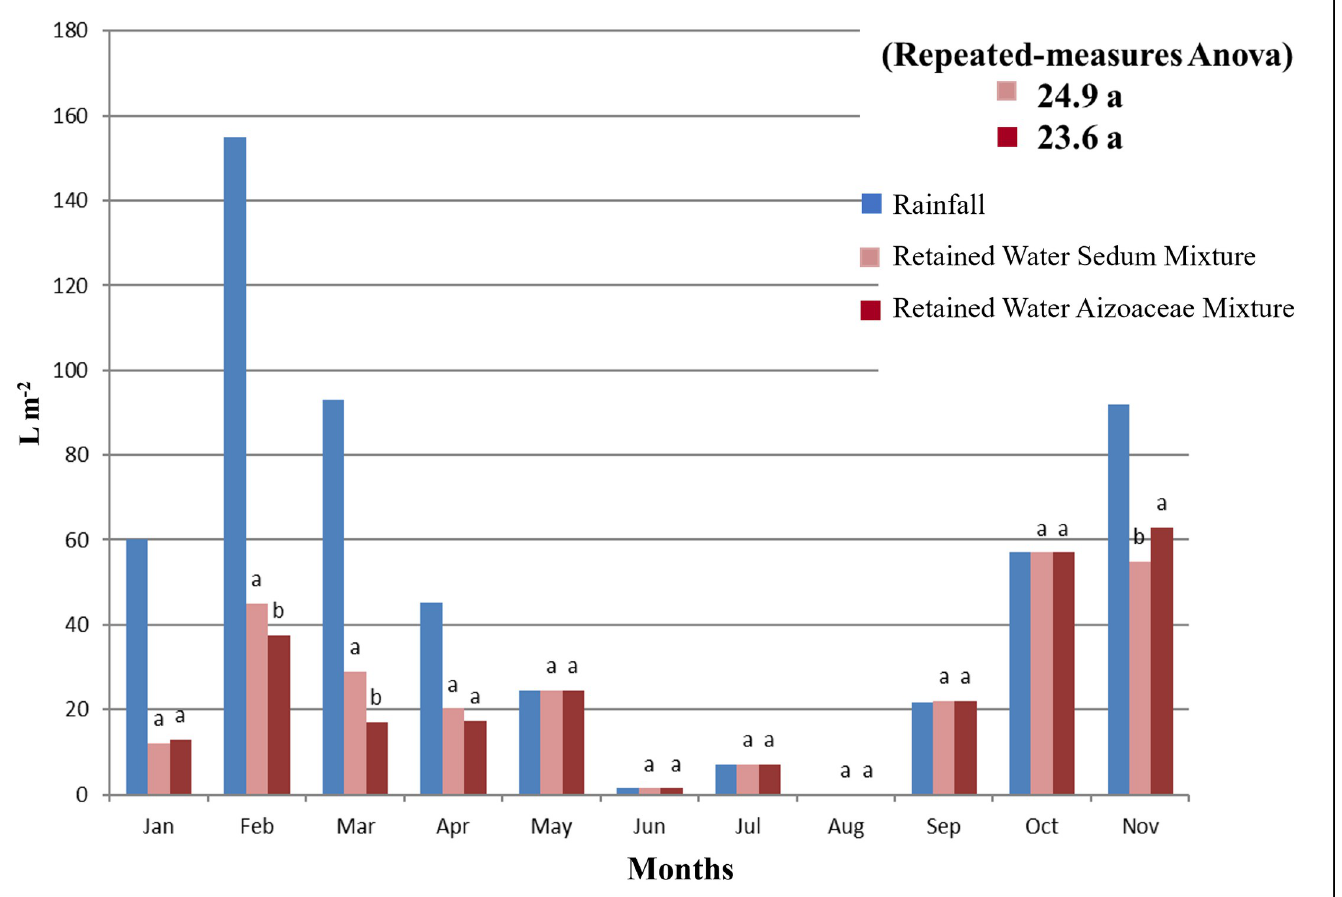
Fig 9. Rainfall retained by the systems year 2012. For each data, histograms with different letters are significantly different at p �